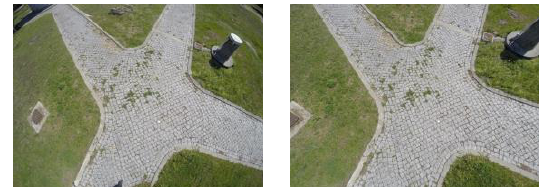
Figure 3. Original image and the corresponding undistorted image obtained with the approximate camera calibration.